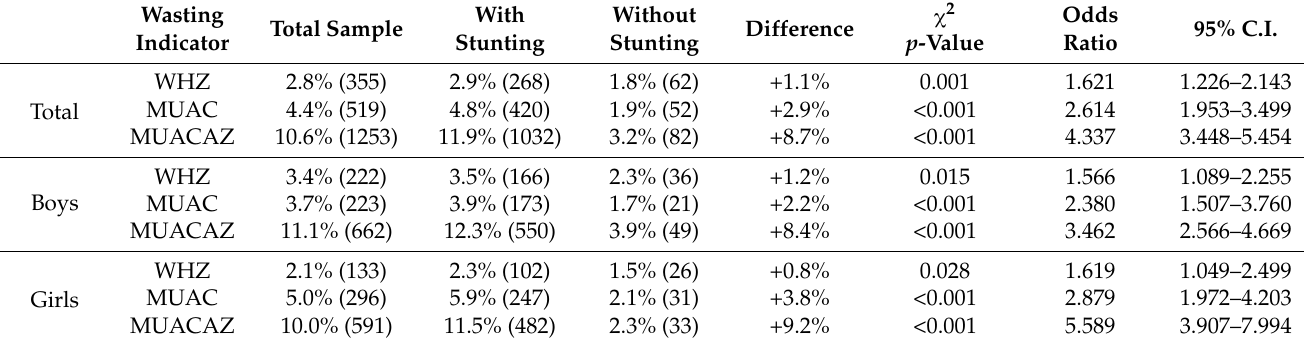
Table 3. Prevalence and probability of wasting as a function of the existence of stunting by